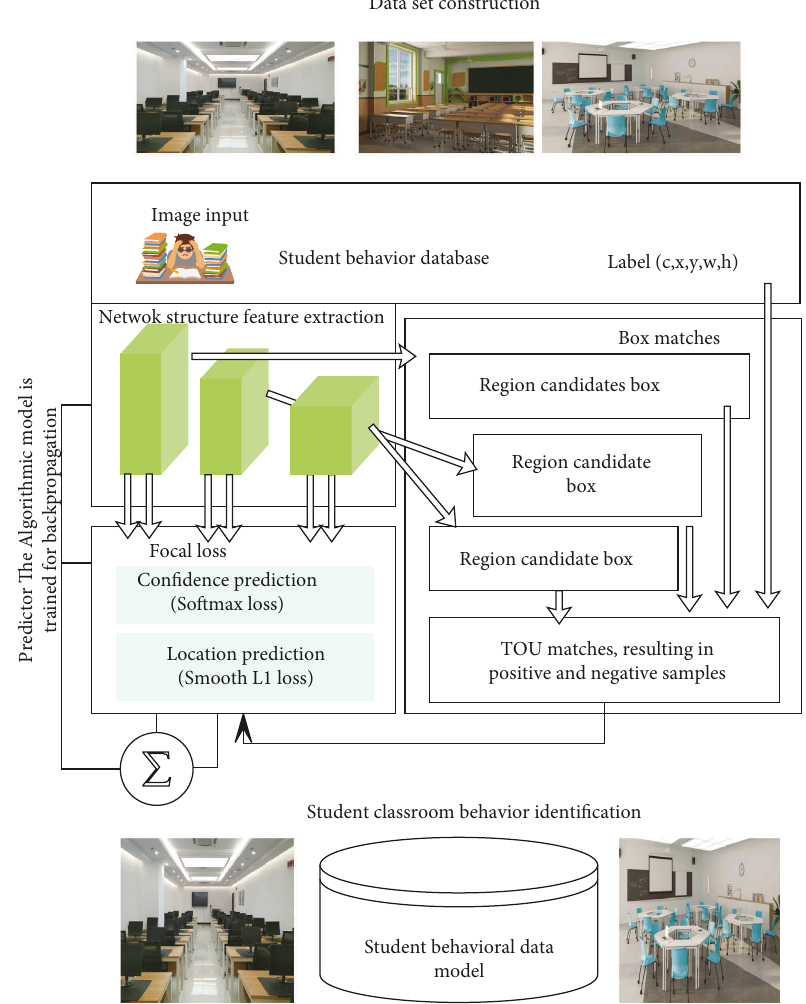
Figure 2: Student status evaluation